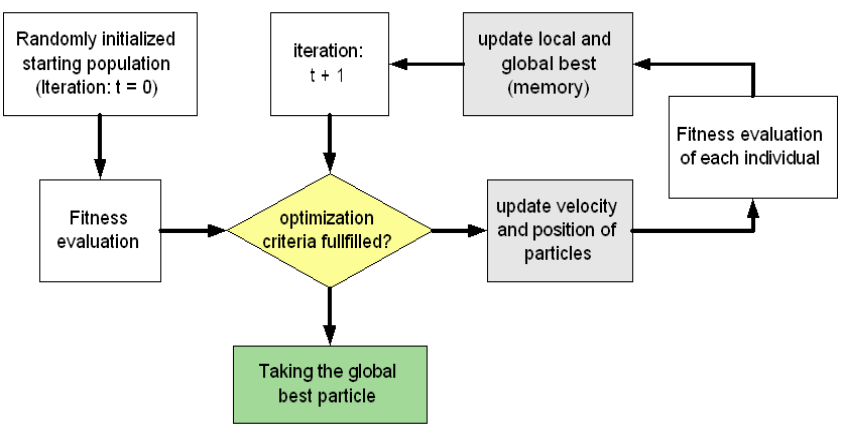
Figure 13. The general process of